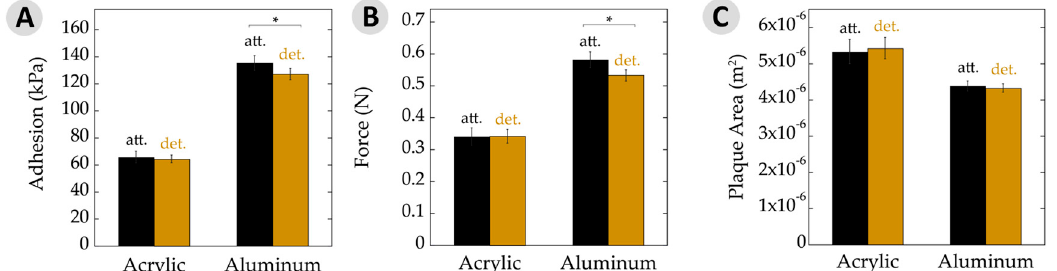
Figure 4. Adhesive properties. ( A ) Average adhesion of attached (att.) and detached (det.) plaques and threads on acrylic and aluminum substrates measured in kilopascals. Adhesion was calculated as a function of removal force divided by plaque area. Note overall increase in adhesion seen on a high surface energy substrate (aluminum) relative to a low energy surface (acrylic); ( B ) Force of byssal removal on acrylic and aluminum substrates measured in newtons; ( C ) Average plaque area deposited on acrylic and aluminum substrates. Note the change in plaque areas on acrylic versus aluminum. Asterisks (*) indicate statistically significant differences ( p ≤ 0.05). All error bars show 95% confidence intervals.